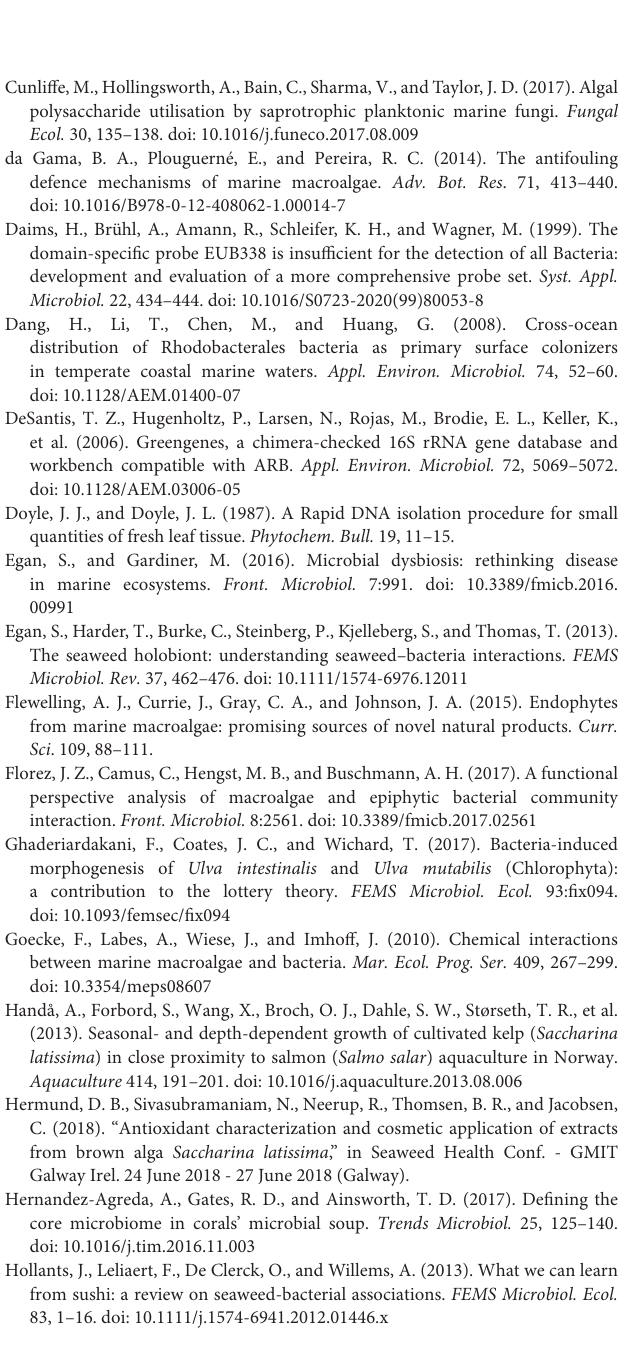
Supplementary Table 1 | Number of observed ASV and Chao-1 values when increasing the number of collected algal pieces in our 16S rRNA genes-based analysis. Supplementary Table 2 | Number of observed ASV and Chao-1 values when increasing the number of collected algal pieces in our ITS genes fragments-based